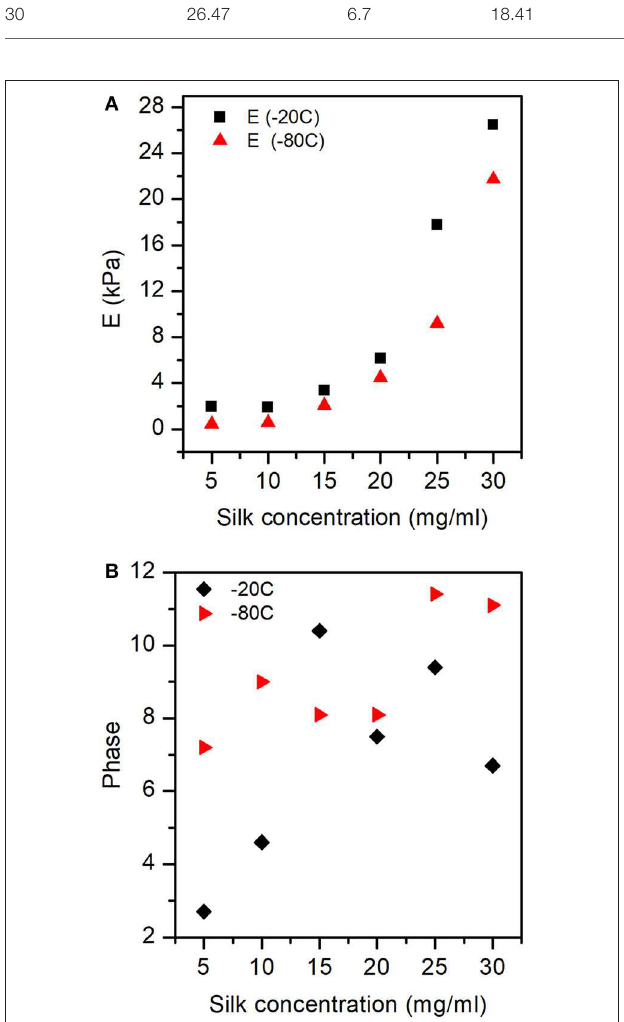
FIGURE 11 | Elastic modulus ( E ), and Phase obtained for the different sponges from the dynamical compression test. (A) The elastic modulus was significantly affected by both silk concentration and process temperature. (B) The phase shows the interplay between storage and loss modulus with silk concentration and process temperature. See Figure S4 for the exact values of E, E’, and E” at − 20 and − 80 ◦ C.